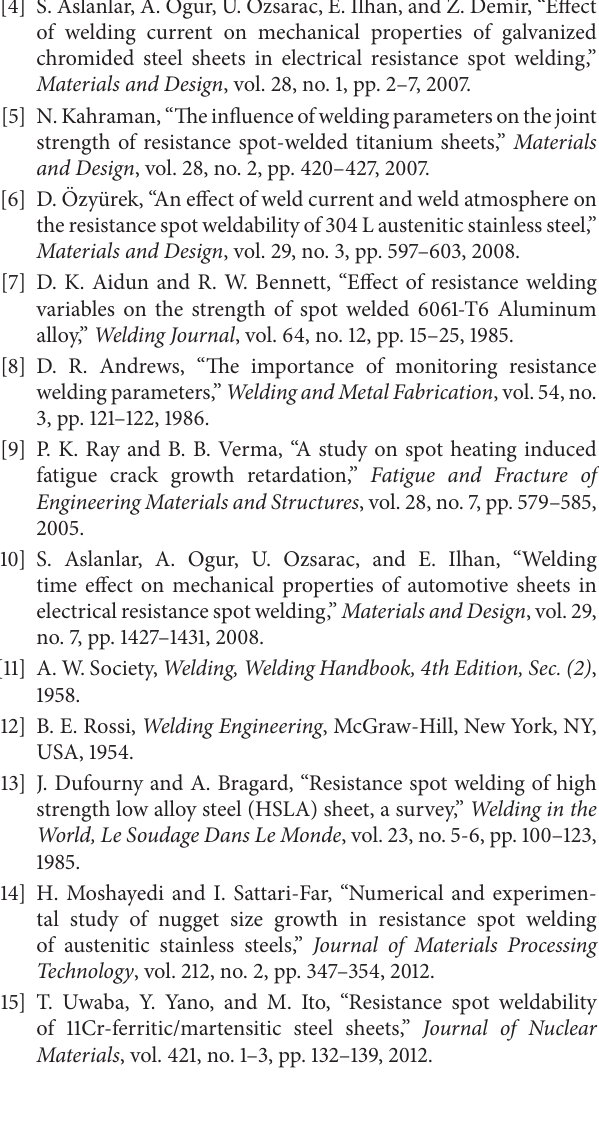
I = 7.2 kA Relation equation-lap Relation equation-peel